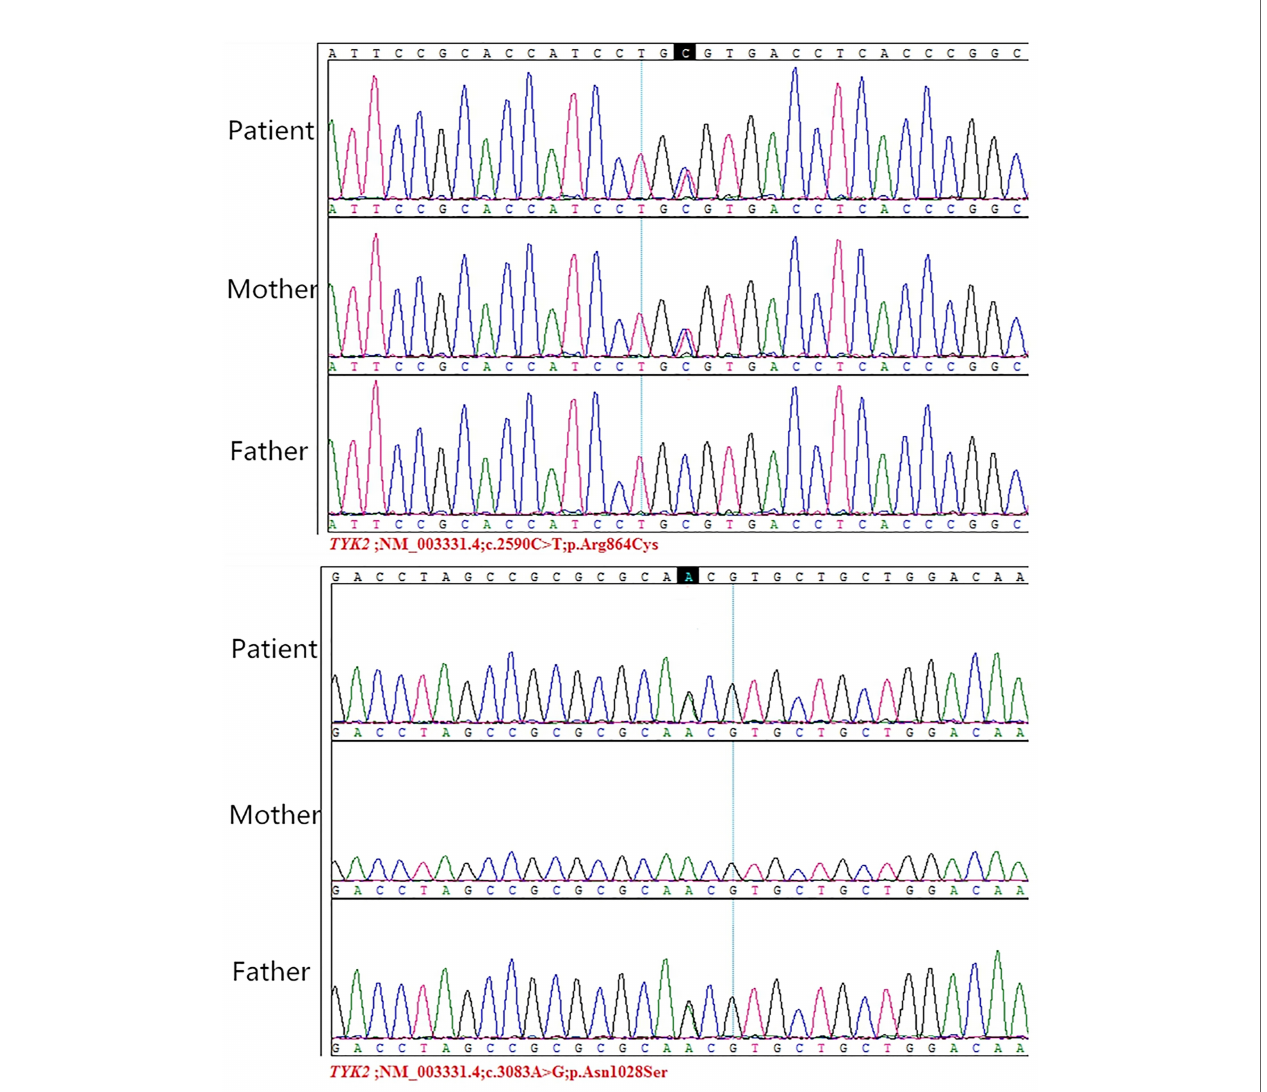
FIGURE 1 | Sanger sequencing of TYK2 mutations in the patient and his parents. Reprinted with permission from Guo, W., Feng, X., Yang, M., Shangguan, Y., Shi, P., Wang, S., et al. (2020). Mycobacterium Intracellulare Infection Associated with TYK2 De fi ciency: A Case Report and Review of the Literature. Infect. Drug.